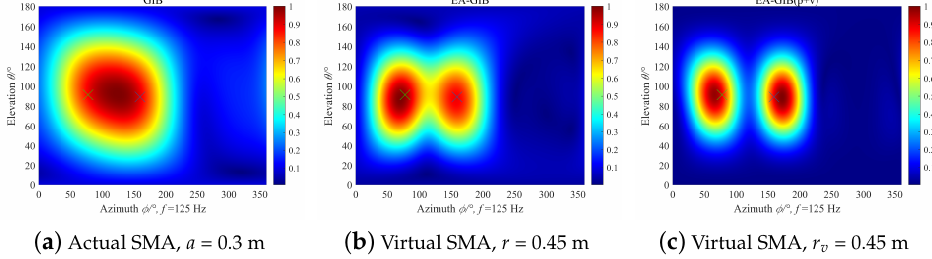
Figure 7. Simulation results of the double sound source with the frequency 125